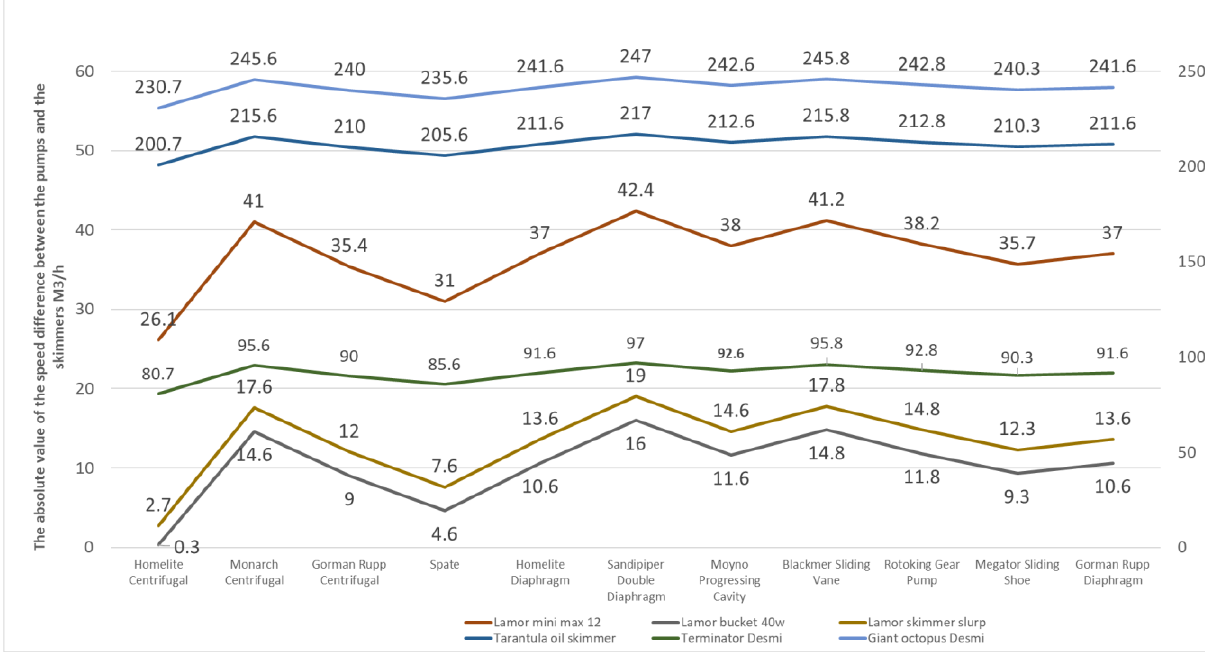
Figure 11 . Analysis of the optimal skimmer – pump combination. Figure 11. Analysis of the optimal skimmer–pump